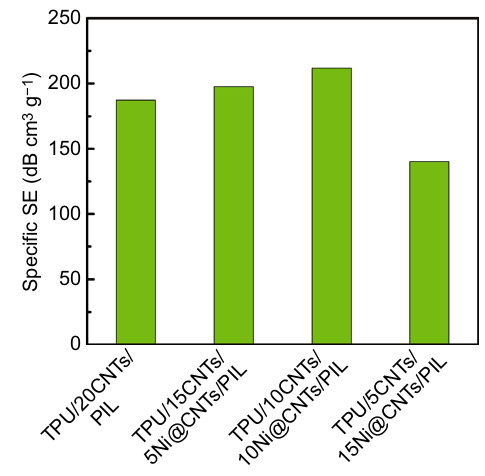
Fig. 8 Specific EMI SE of TPU/CNTs/Ni@CNTs/PIL composite foams with various filler concentrations and the evaporate time of 120 min at 9.0 GHz